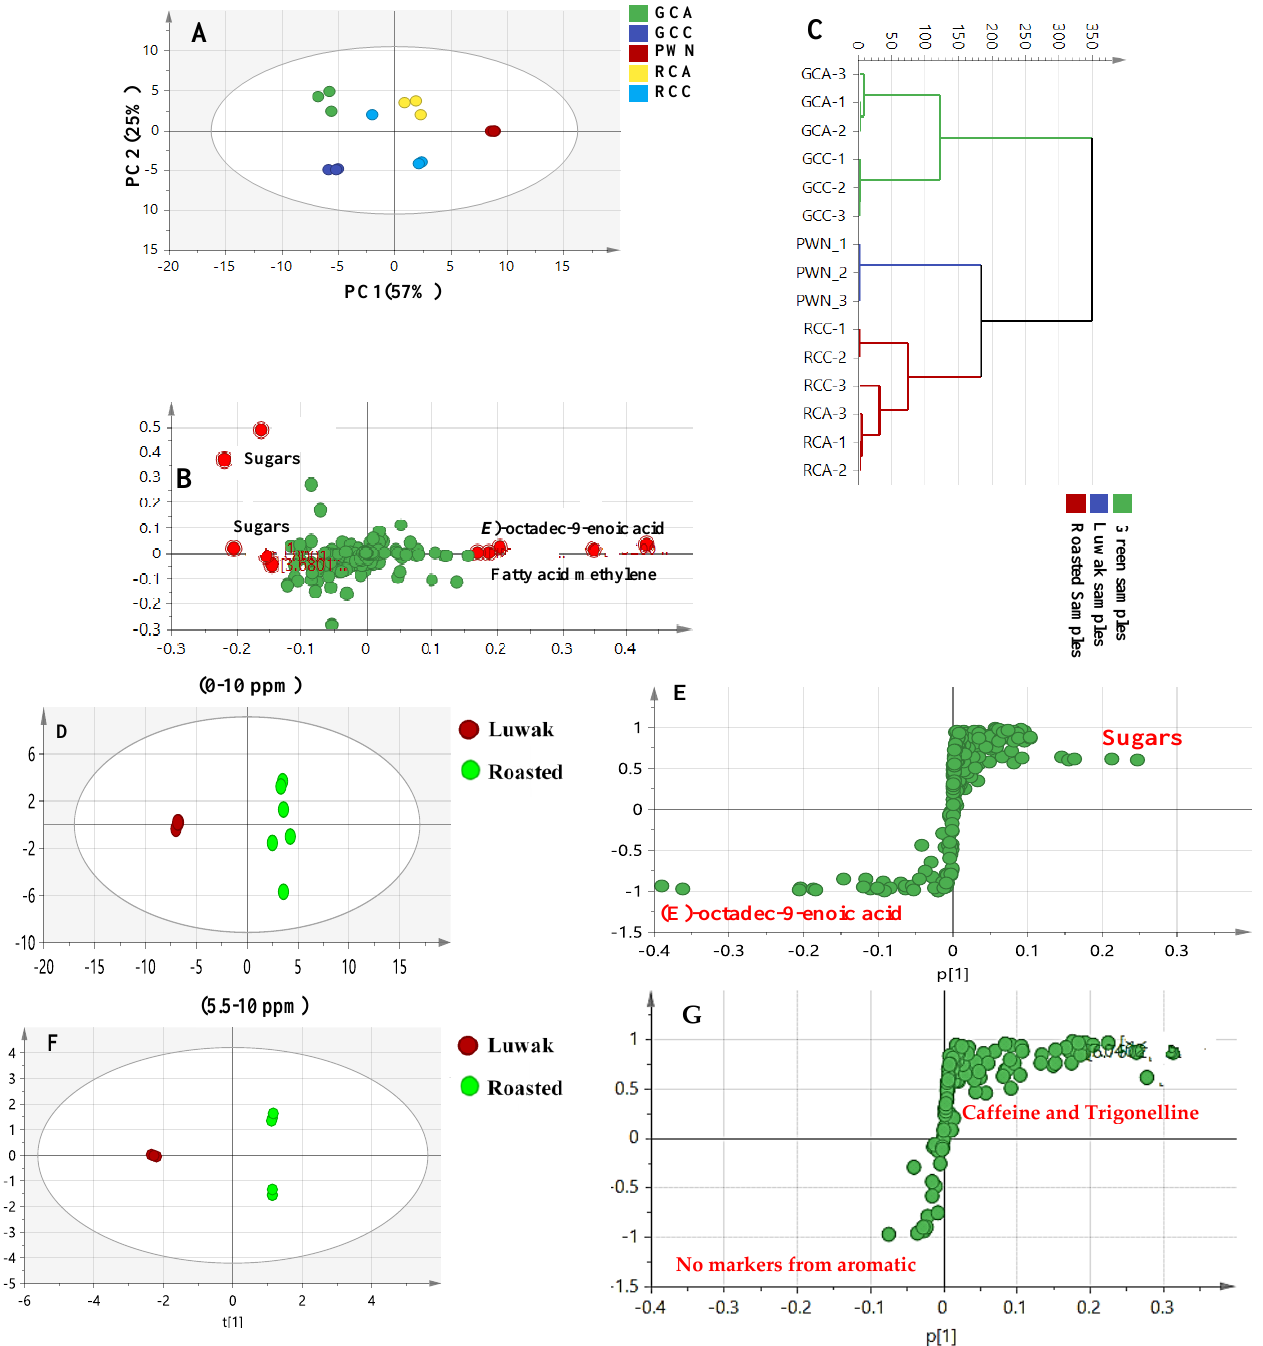
Figure 3. ( A ) The principal component analysis (PCA) score plot. ( B ) The loading plot of all the coffee samples, analyzed using NMR. ( C ) Hierarchical cluster analysis (HCA) plot. ( D ) OPLS-DA model for the roasted samples (RCA and RCC) vs. the Luwak coffee (PWN). ( E ) The S-loading plot showing the covariance p [1] against the correlation p (cor) [1], analyzed by 1 H NMR, shown at a full scale ( F ) OPLS-DA score plot for the roasted samples versus the roasted aromatic region. ( G ) The S-loading plot for the aromatic region. Selected variables are highlighted and discussed in the text.